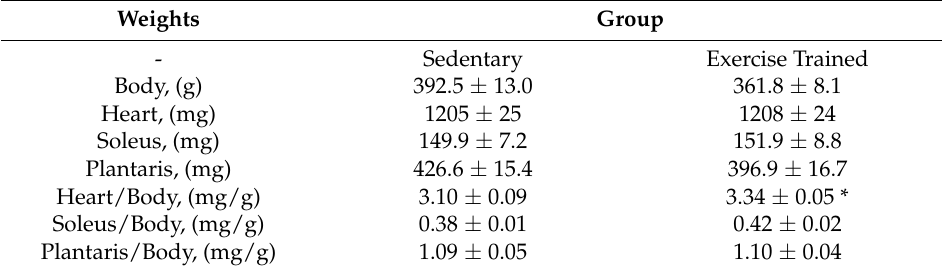
Table 1. Body, heart, and skeletal muscle weights in sedentary and exercise-trained rats. N = 12 per group. Values are expressed as mean values ± SE. * P < 0.05 vs. sedentary.